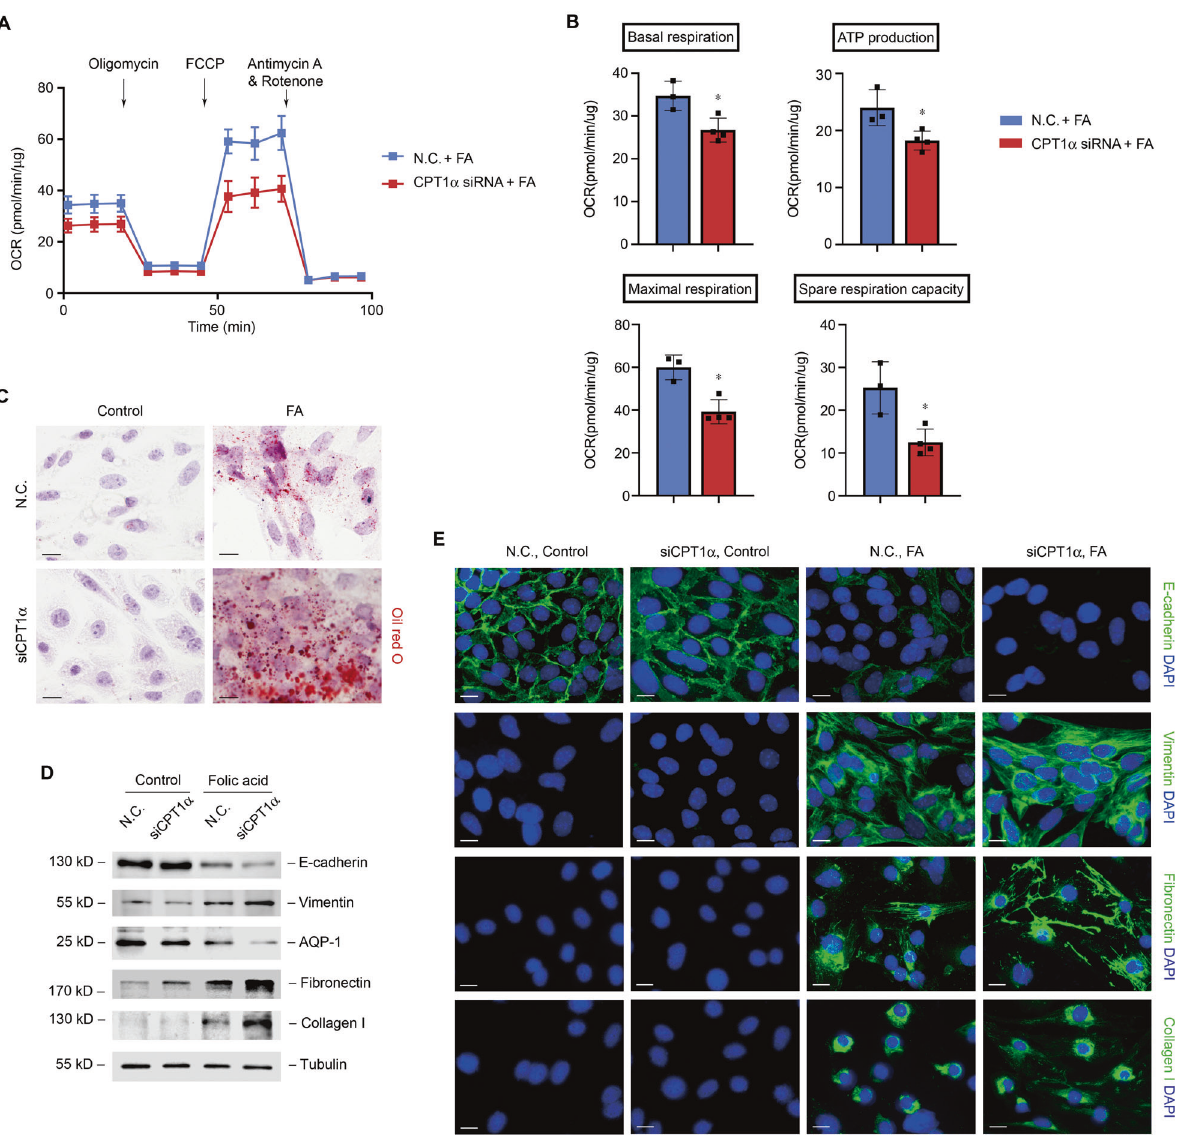
Fig. 7 Tubular cells with reduced CPT1 α are more sensitive to folic acid-induced alternation. A Representative traces show OCR in folic acid-treated tubular cells after transfection with N.C. or CPT1 α siRNA. Oligomycin, FCCP, antimycin A, and rotenone were added where indicated. B Summary OCR data from 3 to 4 independent experiments are shown. * P < 0.05 versus N.C. + FA. C Representative images of tubular cells exposed to treatments as indicated stained with oil red O. D Western blot analysis of protein expression of E-cadherin,